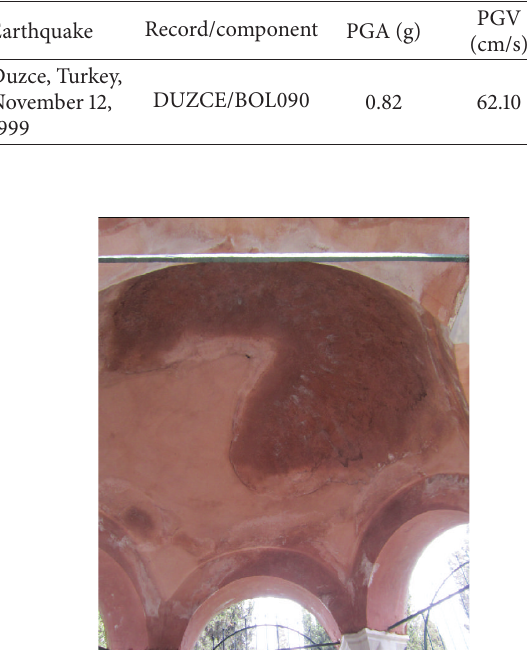
Table 1: Characteristics of the earthquake used in the analysis.